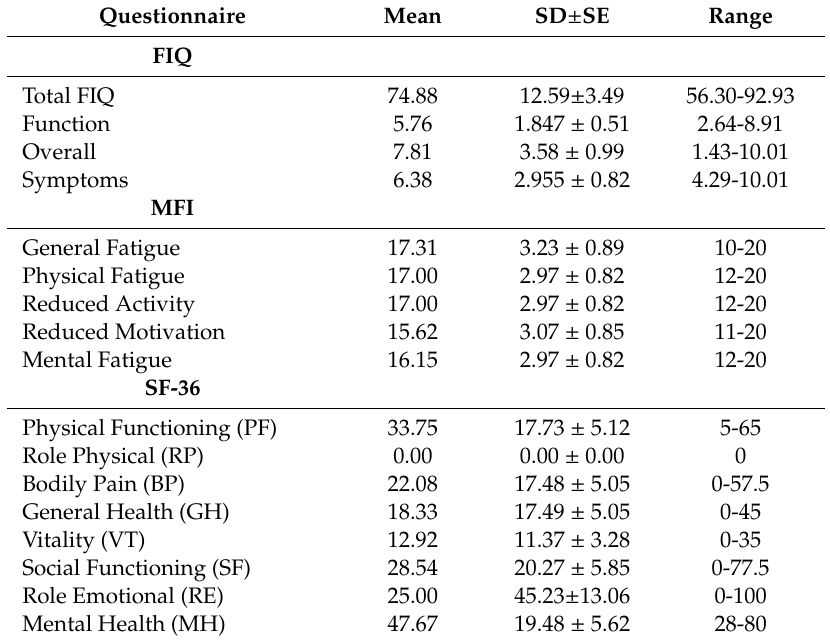
Table 1. Patient assessment with FIQ, MFI and SF-36 [36–39] questionnaires (N =